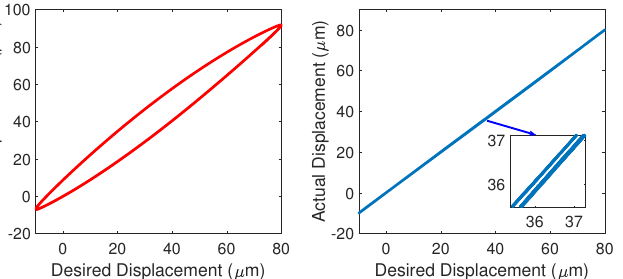
Figure 16. Hysteresis loops in 10 rad/s generated with open-loop status ( left ) and closed-loop status via the proposed strategy ( right ).